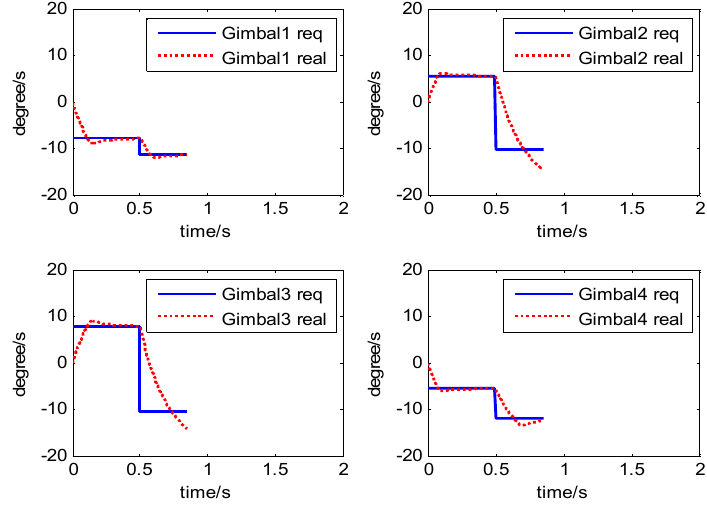
Figure 24. The gimbal rate of four magnetically suspended SGCMGs.